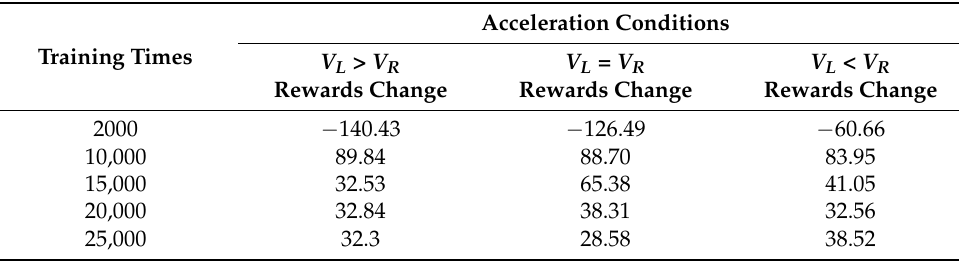
Table 4. Variation of reward function values under different acceleration conditions between both confrontation sides of the detection- interference confrontation.